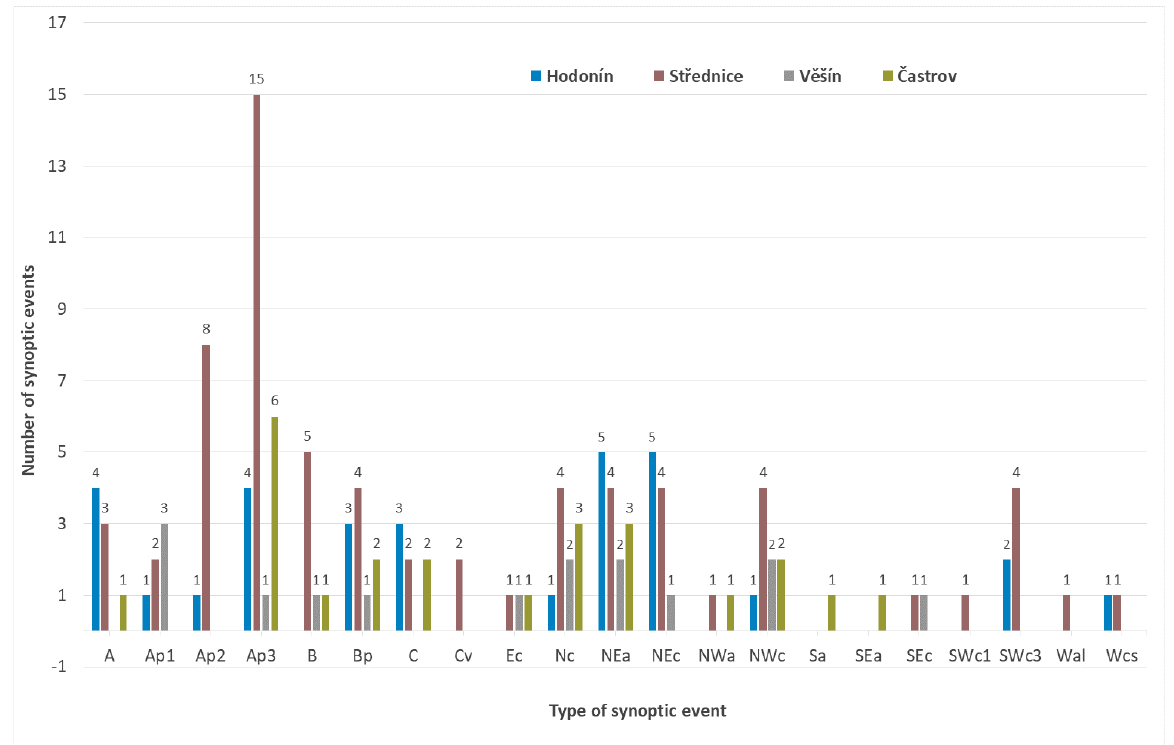
Figure 6. Frequency of synoptic events occurrence in the period of the cherry tree flowering during days with Tmin < -1.1 °C (period of 1961 – 2012).